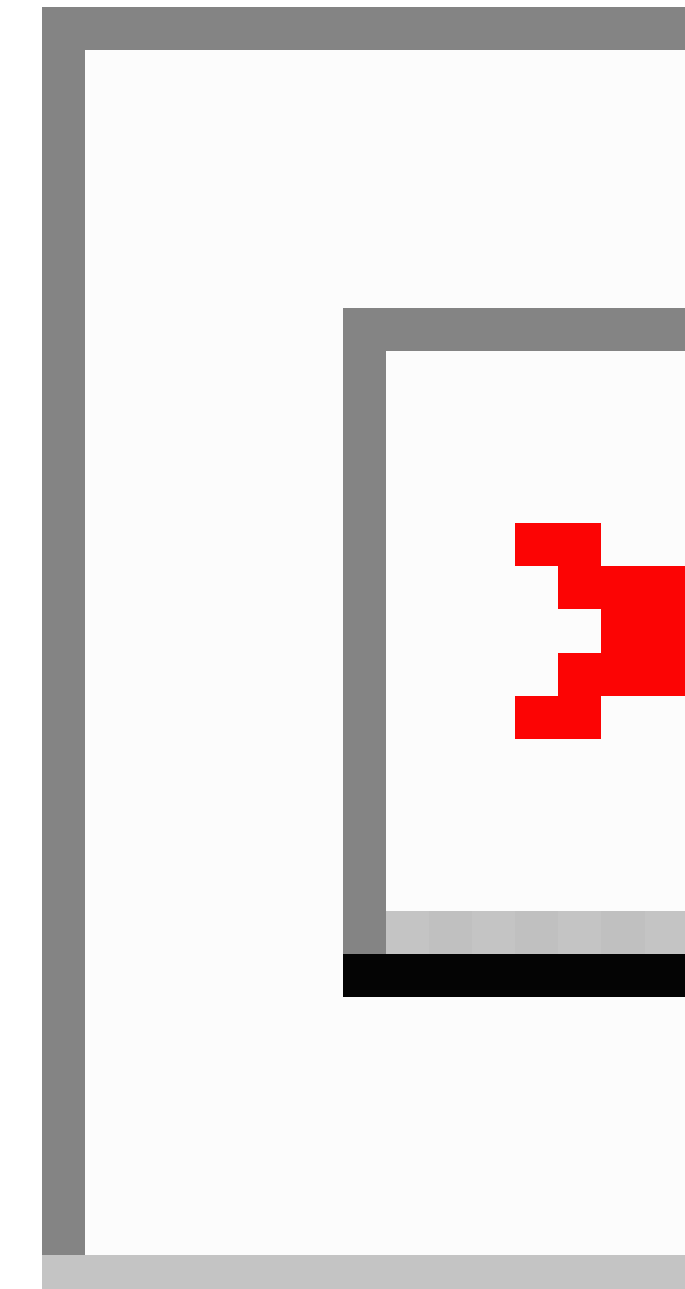
Figure 2. Critical Data poster session. Photo credit: Andrew